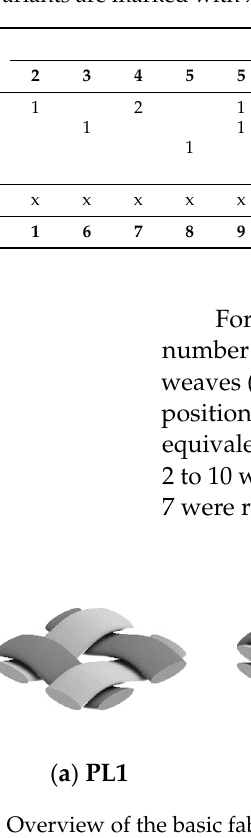
** according to Figure 1.